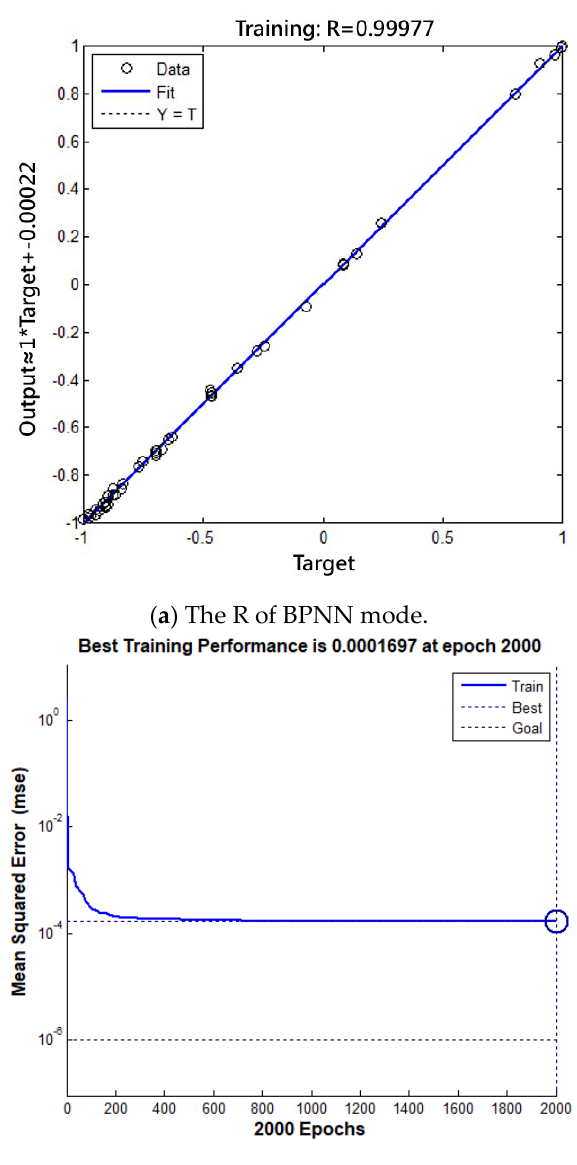
Figure 9. The R and MSE of BPNN model.